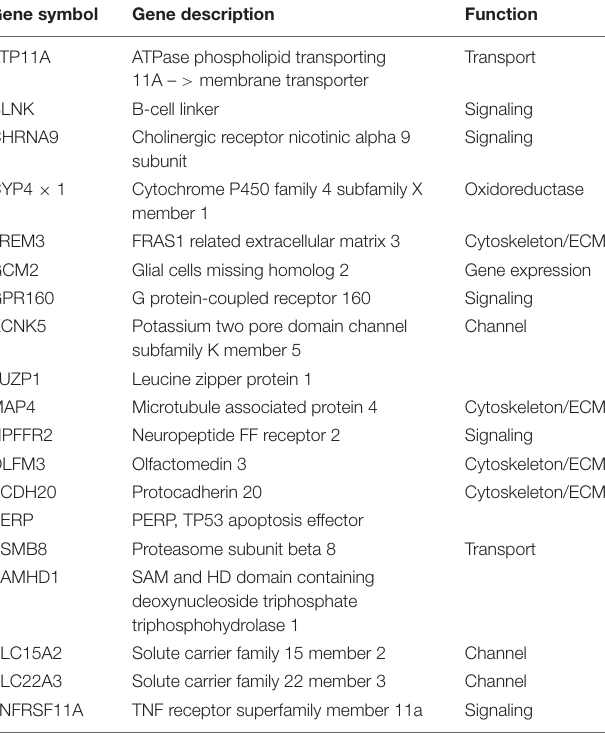
TABLE 1B | Genes specifically enriched in the embryonic